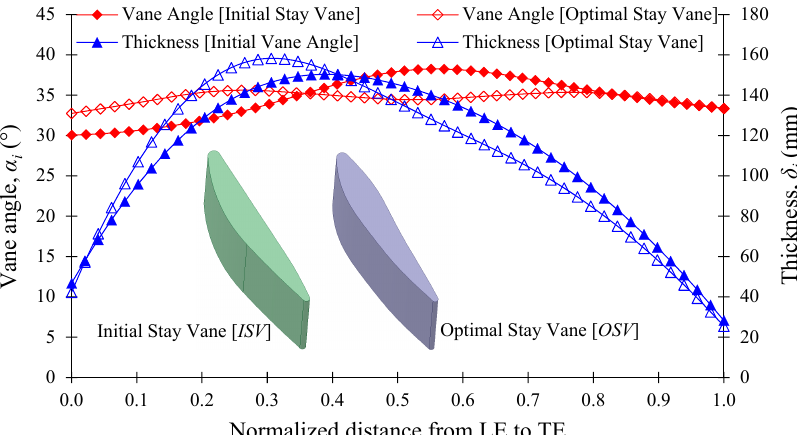
Figure 14. Validation of conceptual design of the 100 MW Francis hydro turbine by CFD analysis.